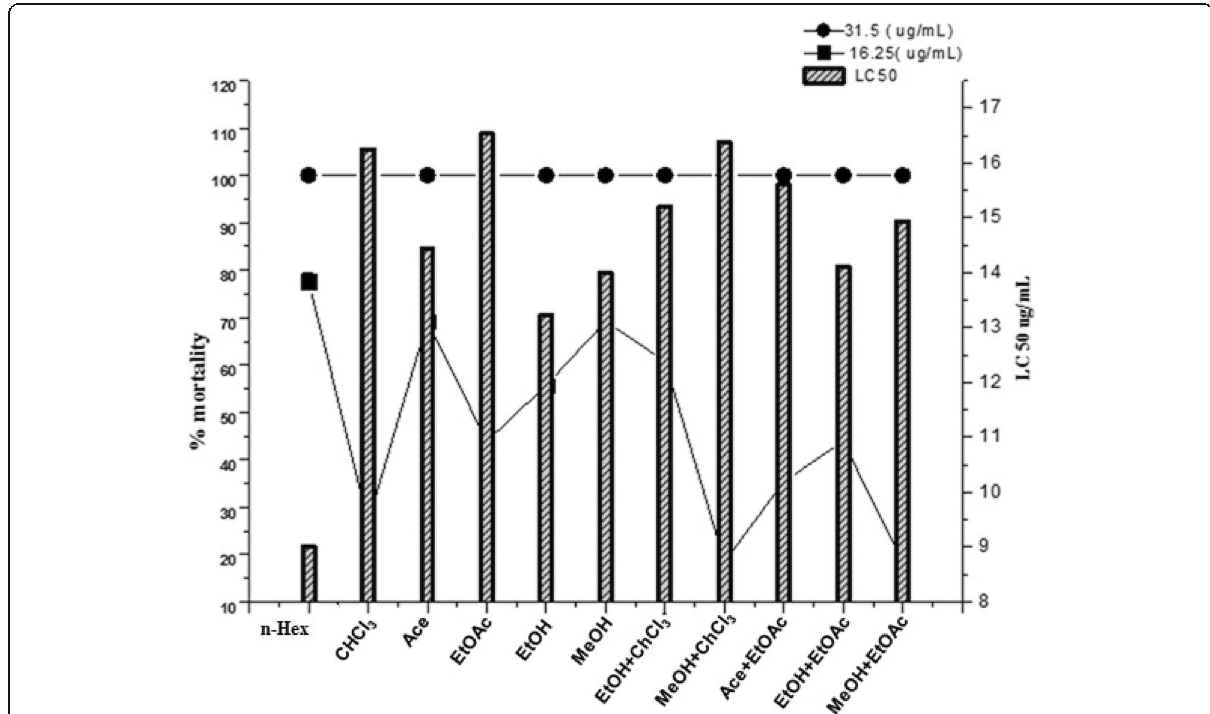
Fig. 2 Percent mortality with corresponding LC 50 ( μ g/ml) of different non polar to polar solvent extracts of A. jacquemontii against brine shrimps larvae